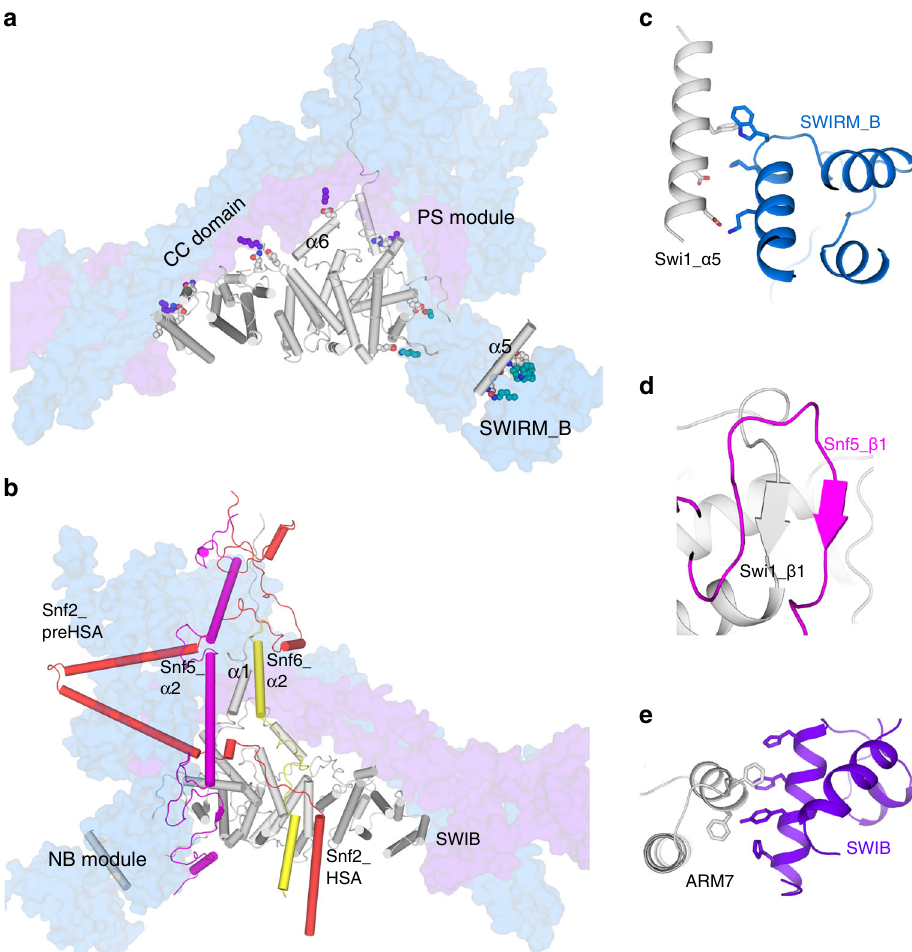
Fig. 2 Swi1 serves as a rigid core. a Interactions between Swi1, Snf12, and Swi3A/B. The residues involved are shown with sphere model. Swi1 is shown as cartoon model colored in gray. Swi3A/B and Snf12 are shown as surface models colored in blue and purple blue, respectively. b Interactions between Swi1, Snf2, Snf5, and Snf6. Snf2, Snf5, and Snf6 are shown as cartoon models colored in red, magenta, and yellow, respectively. c The α 5 interacts with SWIRM_B domain. d The β sheet formed by Swi1_ β 1 and Snf5_ β 1. e The interface between ARM7 from Swi1 and SWIB domain from